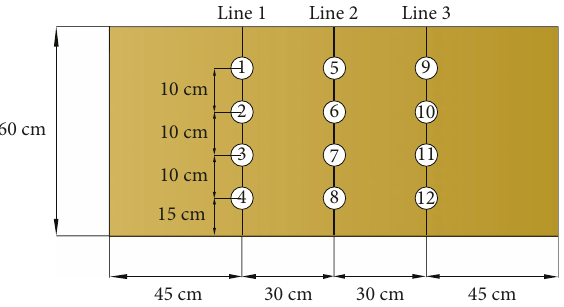
Figure 6: Layout of monitoring points for surface